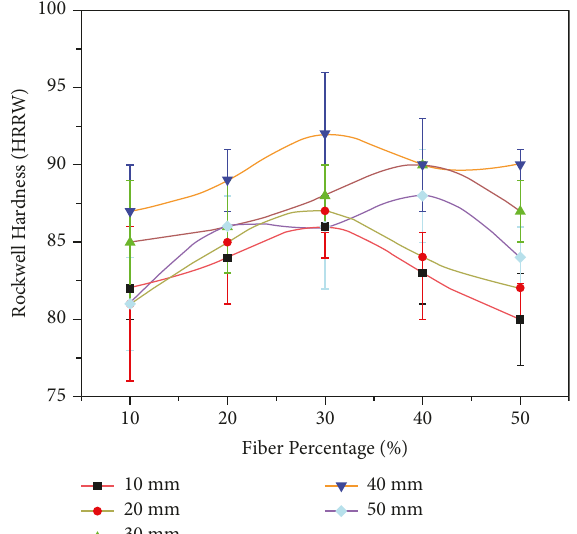
Figure 5: Effect of fiber length and weight percentage on Rockwell